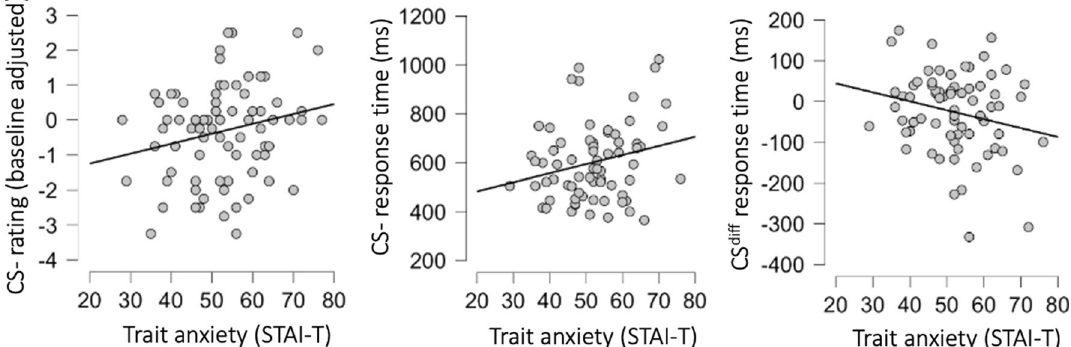
Figure 5. Associations between trait anxiety and learning variables. Scatter plots and linear fit lines showing correlations between trait anxiety, measured with Spielberger State-Trait Anxiety Inventory-trait version (STAI-T) and (left) negative affective ratings to conditioned stimulus never paired with an aversive outcome (CS−), (middle) response time to early probes presented during CS−, and (right) difference in response time between probes presented during stimuli paired with and aversive outcome (CS +) and CS−. A negative difference score indicates that CS+ responses were faster than CS− responses, and thus reflects stronger